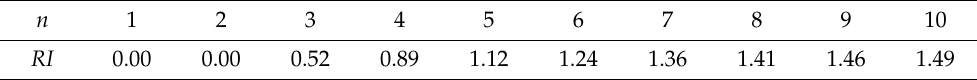
Table 2. Mean random consistency index.